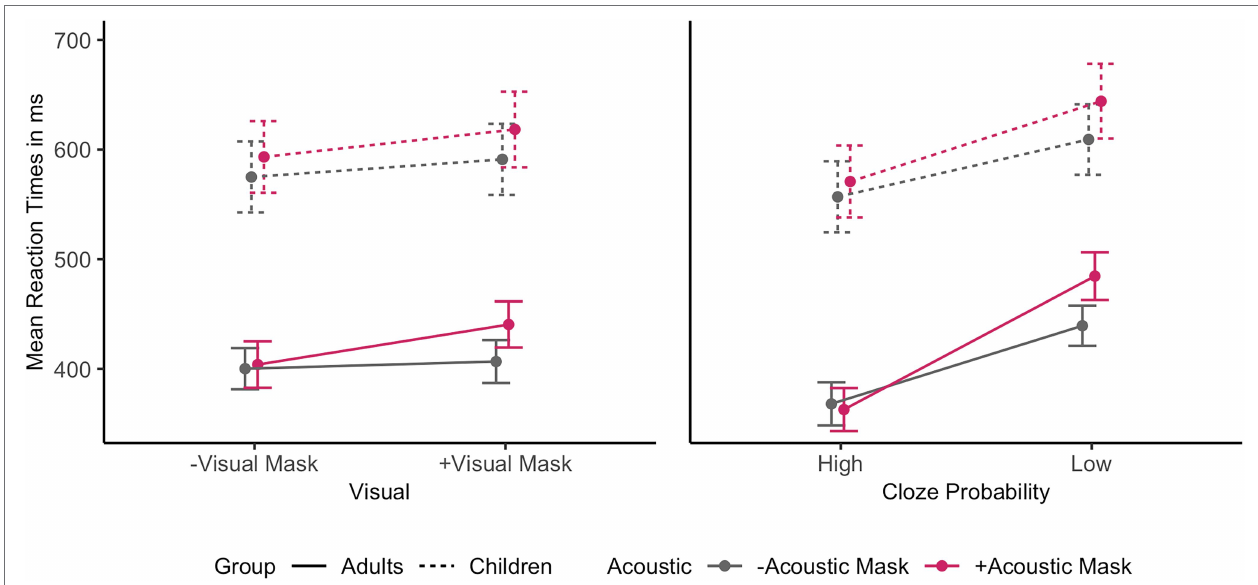
FIGURE 5 | Interaction effects on mean reaction times in ms (with error bars) by Age Group based on the raw data (on the left: Acoustic Mask*Visual Mask; on the right: Acoustic Mask*Cloze Probability). Interactions in the mixed-model analysis were significant only for the adult comparisons (solid lines).